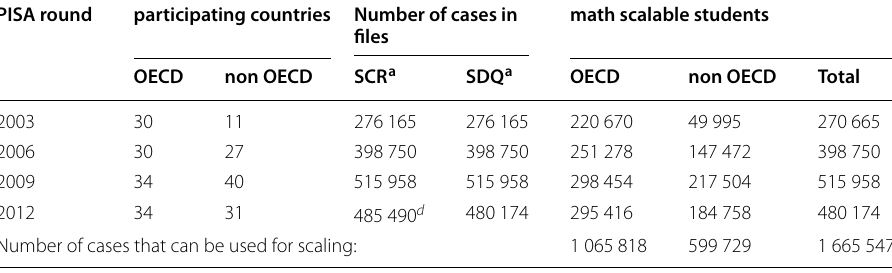
Table 1 Overview for cross‑sectional OECD PISA data files and resulting total database of scalable cases for